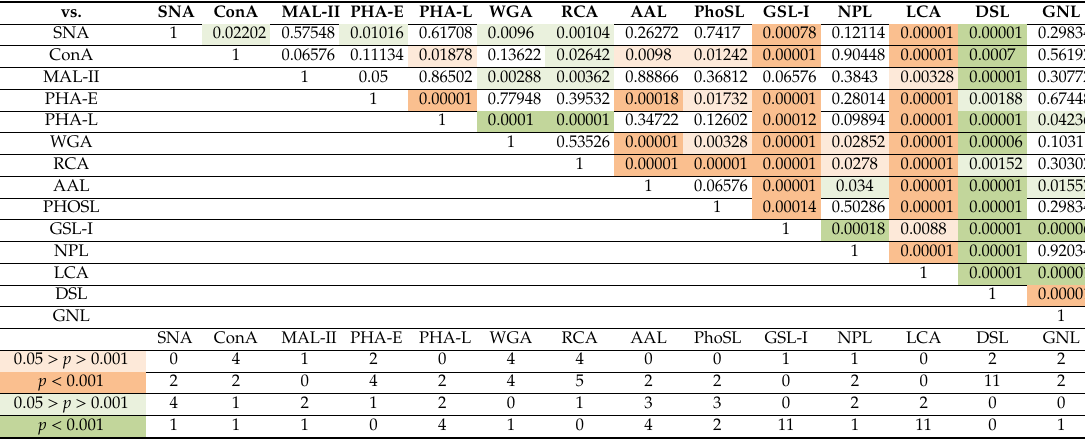
Table 4. Mann-Whitney U analysis of the lectin / lectin ratios of signals obtained using the lectin-based microarray. vs.